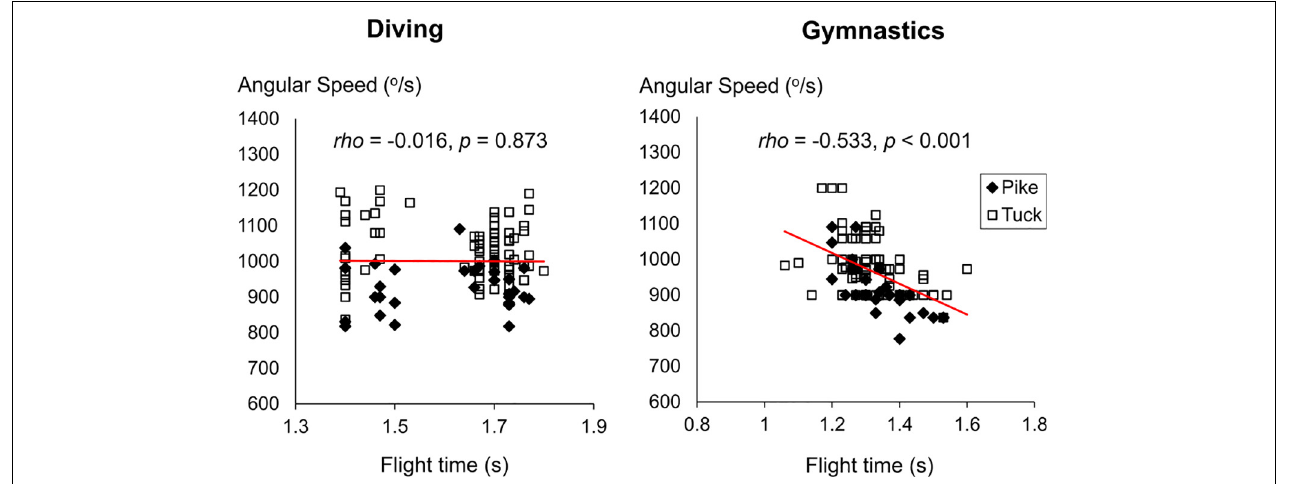
FIGURE 5 | Spearman’s correlations between angular speed and flight time for multiple back 3.0 or 3.5 somersaults in diving and gymnastics.